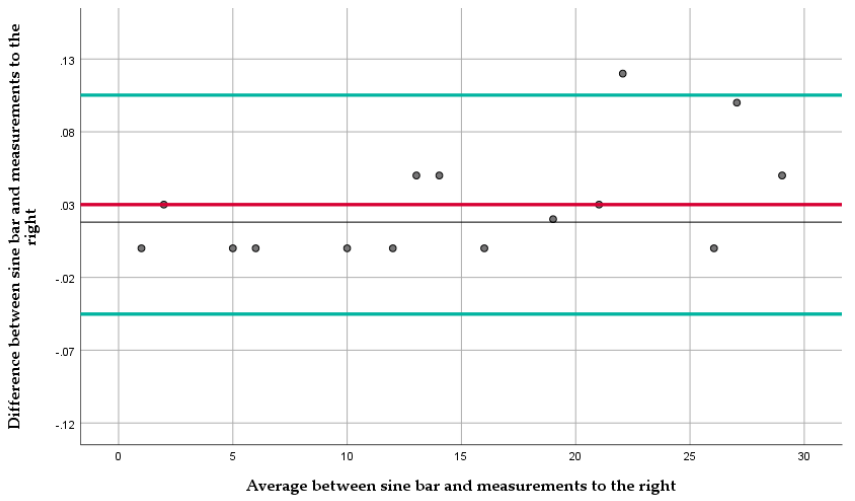
Figure 5. The Bland-Altman plot for measurements to the right. The red line represents the average difference between the sine bar set angles and the mean measurements, and the green lines, the 95% CI.